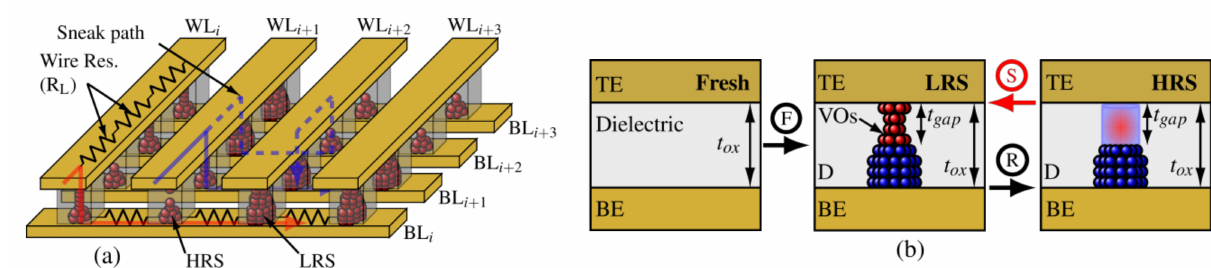
Figure 1. ( a ) Sketch of the CPA structure. Red and blue arrows exemplify the electron flow through the memdiodes connecting the top (word lines (WL)) and bottom lines (bit lines (BL)). Different resistance states are schematically represented (high resistance state (HRS) to low resistance state (LRS)). The dashed blue line depicts the so-called sneakpath problem. The parasitic wire resistance is indicated for WL i and BL i . ( b ) Schematic representation of the MIM structure where the RS mechanism takes place, before the forming step and during the LRS-to-HRS alternate transition. Blue and red balls represent the metal ions and oxygen vacancies (VOs),